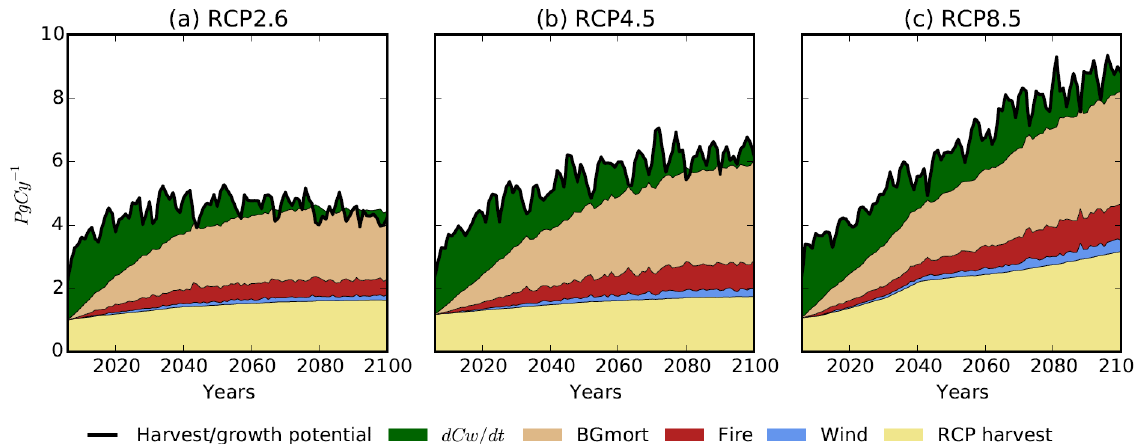
Figure 3. Composition of growth-based harvest (GB) forced by different climate change scenarios (RCP2.6, RCP4.5, and RCP8.5 in panels a , b , and c , respectively). dCw / d t refers to the difference in changes in above-ground woody biomass between Representative Concentration Pathways’ and GB harvest (where changes in biomass in GB are by construction of the harvest rule close to 0), BGmort refers to the difference in woody carbon losses between RCP and GB harvest due to background mortality, fire refers to that due to fire disturbance, and wind refers to that due to wind disturbance. GB and RCP harvest are as in Fig.